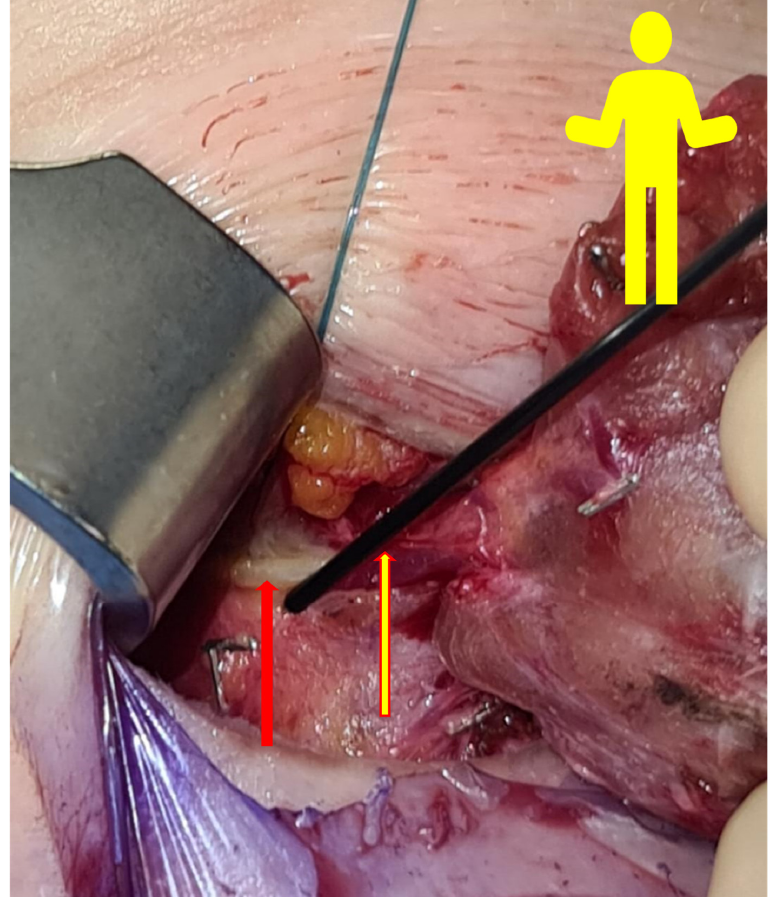
Figure 3. The yellow figure simulates the patient’s position on the OT table. The red arrow shows the first non-RLN type 1. The yellow arrow shows the stimulation probe of the NIM Vital™ (Medtronic Xomed, Inc., Jacksonville, FL, USA).